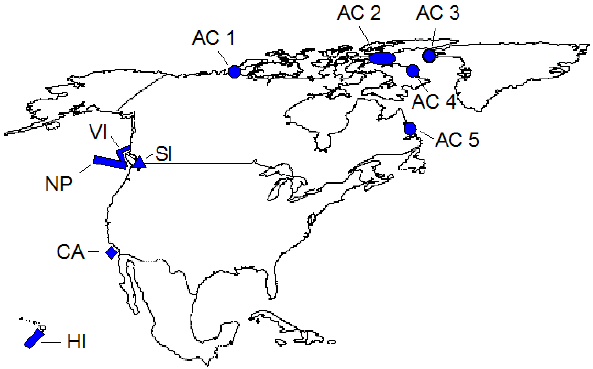
Fig. 1. Sampling stations. AC: Arctic; CA: California, Santa Bar- bara Channel; HI: Hawaii; NP: North Pacific; SI: Saanich Inlet; VI: Vancouver Island, West